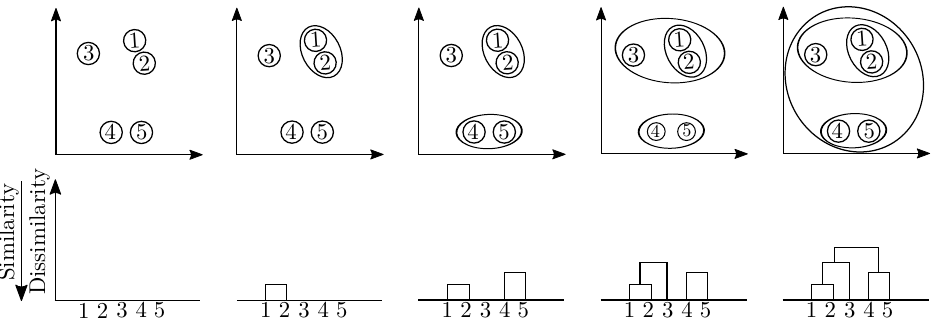
Figure 1. Working principle of the hierarchical clustering